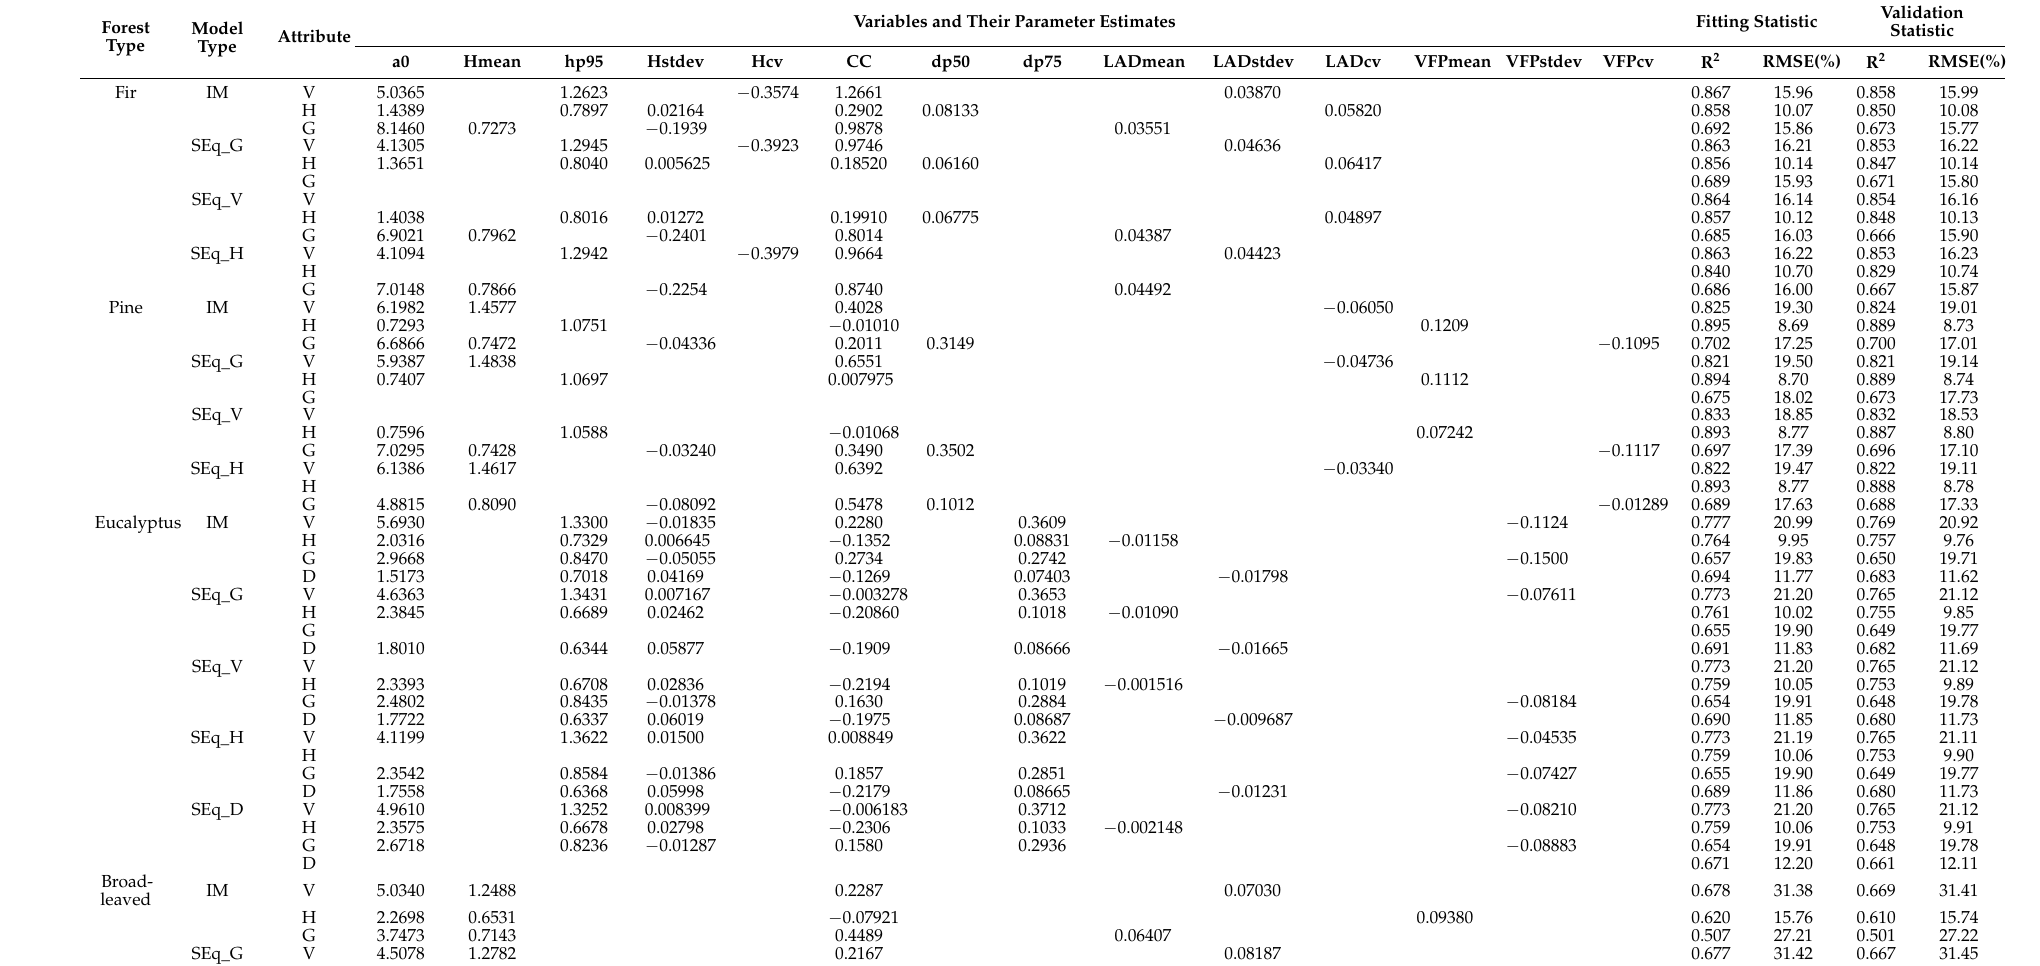
Table 3. The parameter estimates of the best independence models and simultaneous equations of varied forest types and their goodness-of-fit